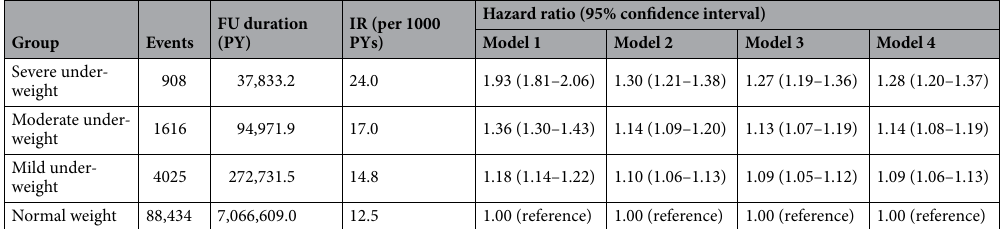
Table 2. Calculated hazard ratios for fracture according to the degree of underweight. Model 1: non-adjusted. Model 2: adjusted for age and sex. Model 3: adjusted for age, sex, smoking status, alcohol consumption, low income, and regular exercise. Model 4: Adjusted for age, sex, smoking status, alcohol consumption, low income, regular exercise, diabetes, hypertension, dyslipidemia, and chronic kidney disease. FU follow-up, IR incidence rate, PY